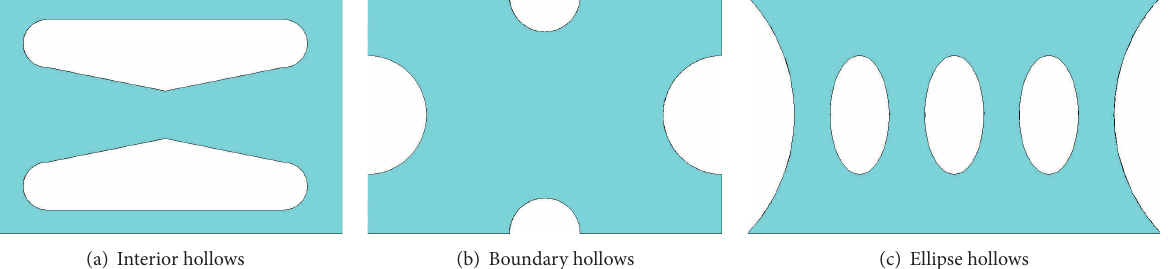
Figure 8: The initial form of damper.